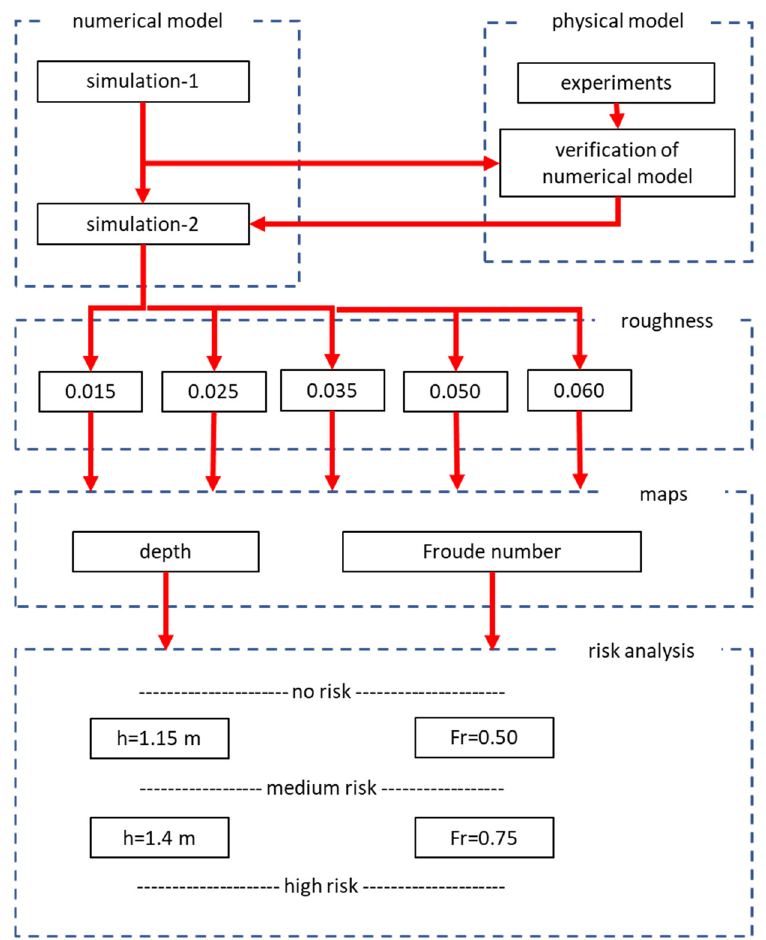
Figure 7. Block scheme of the designed analysis steps linking hydrodynamic simulations, laboratory tests, and geoprocessing. tests, and